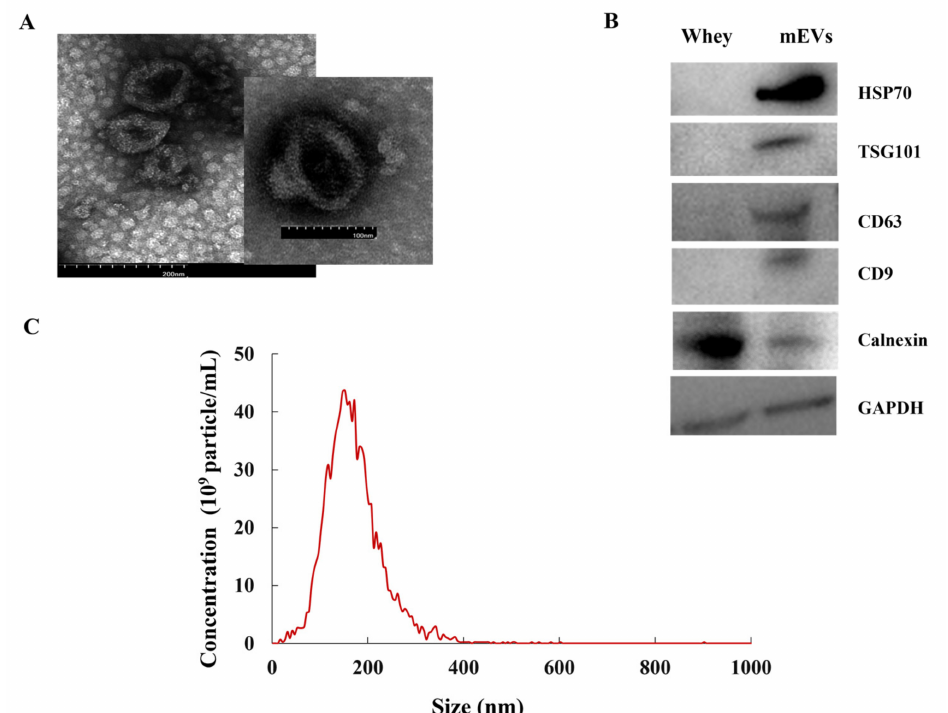
Figure 1. The characterization of mEVs. ( A ) The image of mEVs by transmission electron microscopy. ( B ) The whey and mEVs samples characterized by Western blot for the presence of markers HSP70, TSG101, CD63, and CD9 and negative mEV-marker calnexin. ( C ) The size distribution and concentra- tion analysis of mEVs by nanoparticle tracking